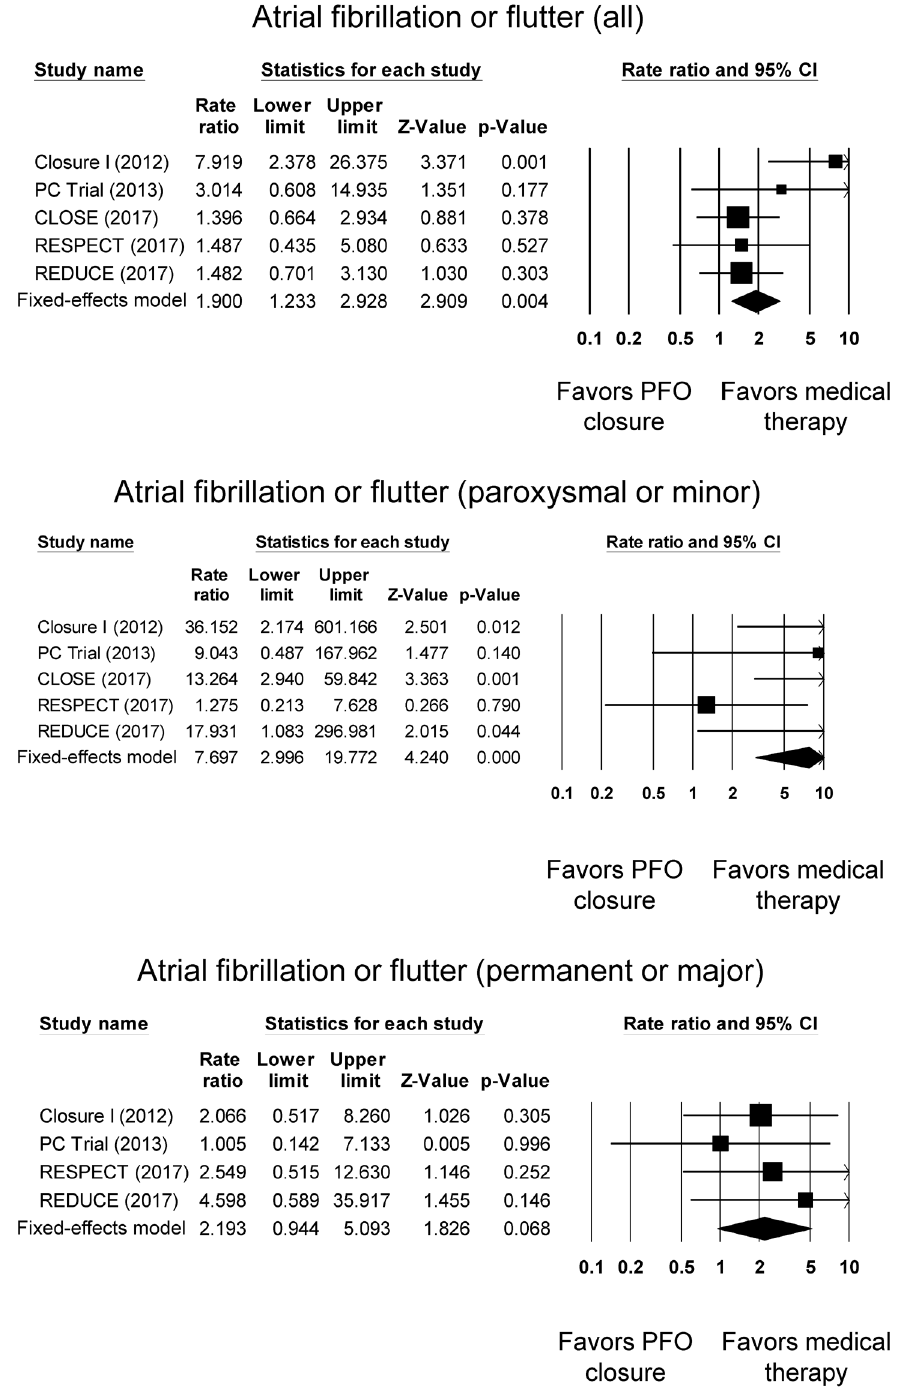
Figure 3. Rate ratios for atrial fibrillation or flutter (all types: top; paroxysmal or minor: middle; permanent or major: bottom) in patent foramen ovale (PFO) closure versus medical therapy.